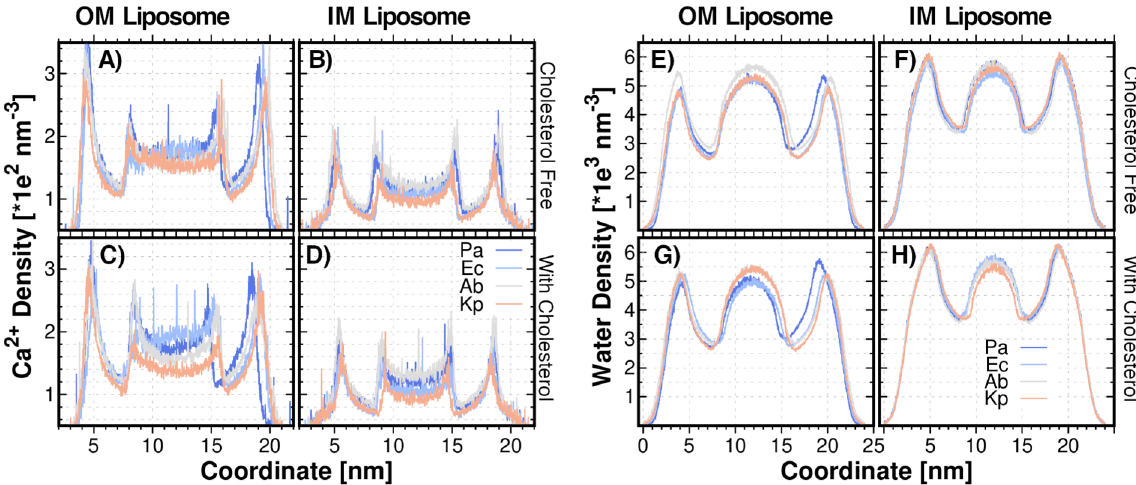
Figure 3. Radial density for ion Ca 2+ and Water beads. Ca 2+ number density in: (A – B) OM and IM liposomes, respectively; (C – D) OM and IM liposomes containing cholesterol, respectively. Water number density in: (E – F) OM and IM liposomes, respectively; and, (G – H) OM and IM liposomes containing cholesterol, respectivel.